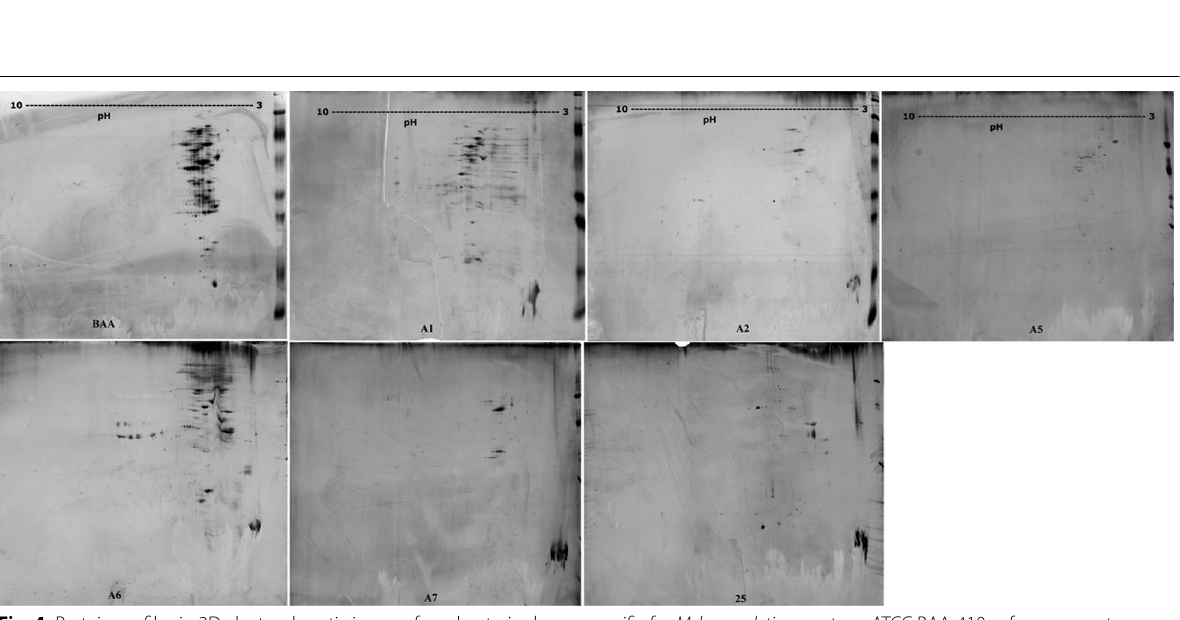
Fig. 4 Protein profiles in 2D electrophoretic images from bacteriophages specific for M. haemolytica serotype ATCC BAA‑410, reference serotypes A1 (P588), A2 (499), A5 (P501), A6 (6174) and A7, and field strain 25 obtained from calves with respiratory syndrome; M—Mol. Weight. Standard 2D (No. Cat. 161‑0320, BioRad,